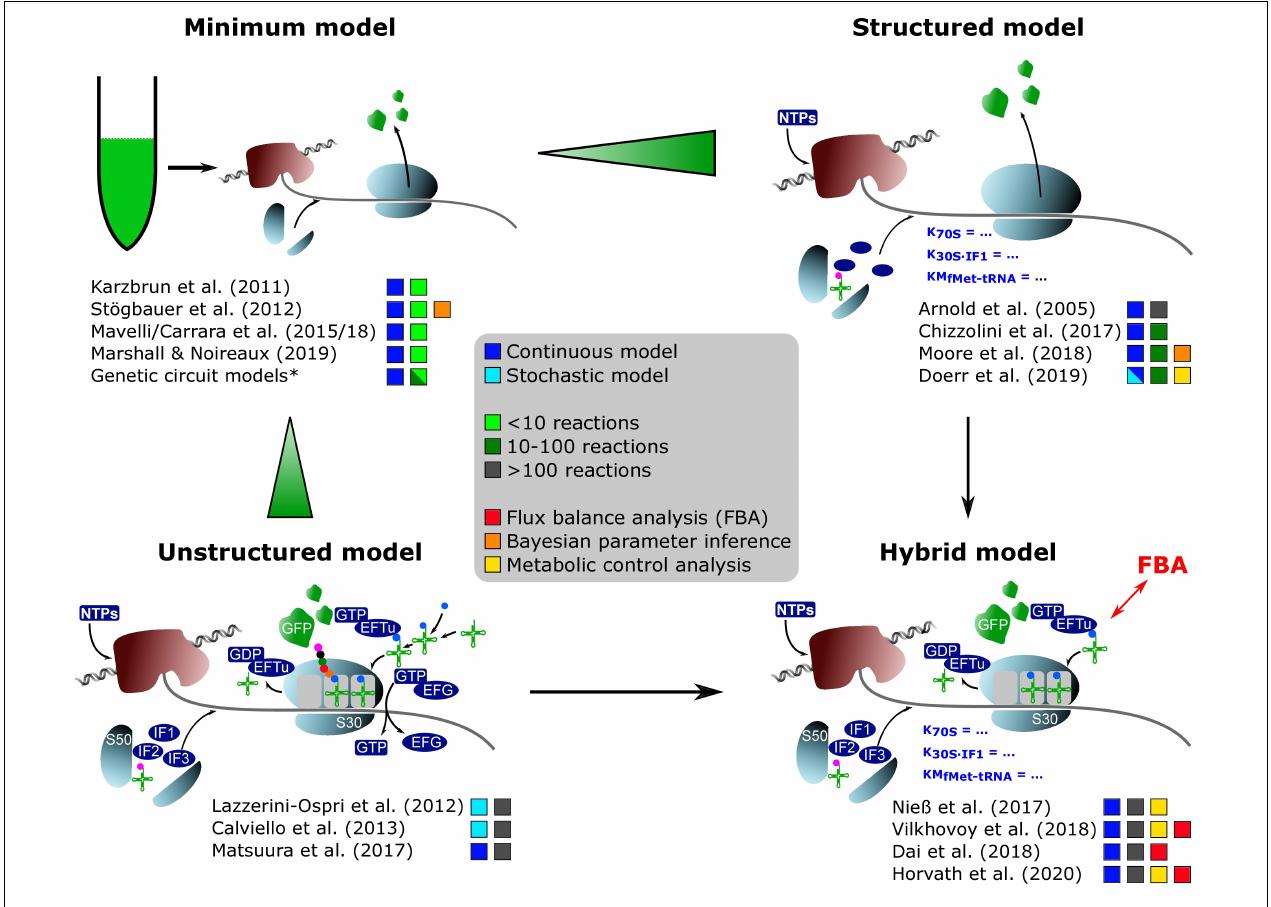
FIGURE 1 | On-trend categorization of CFPS models with respect to the defined model levels “minimum,” “structured,” “unstructured,” and “hybrid.” Color-coded squares indicate model classes, size, and particular features. The transition from “minimum” to “structured” considers the implementation of detailed kinetics. In contrast, the shifting from “minimum” to “unstructured” extends the reaction network and kinetic complexity. “Hybrid model” represents a tradeoff between “structured” and “unstructured” approaches. NTPs, nucleoside triphosphates; S50/S30, ribosomal subunits; EFTu, elongation factor Tu; EFG, elongation factor G; IF1/IF2/IF3, initiation factors; GFP, green fluorescent